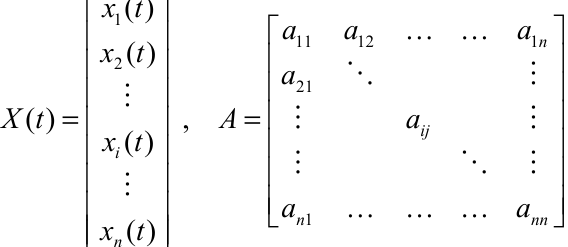
ij to x to improve j i